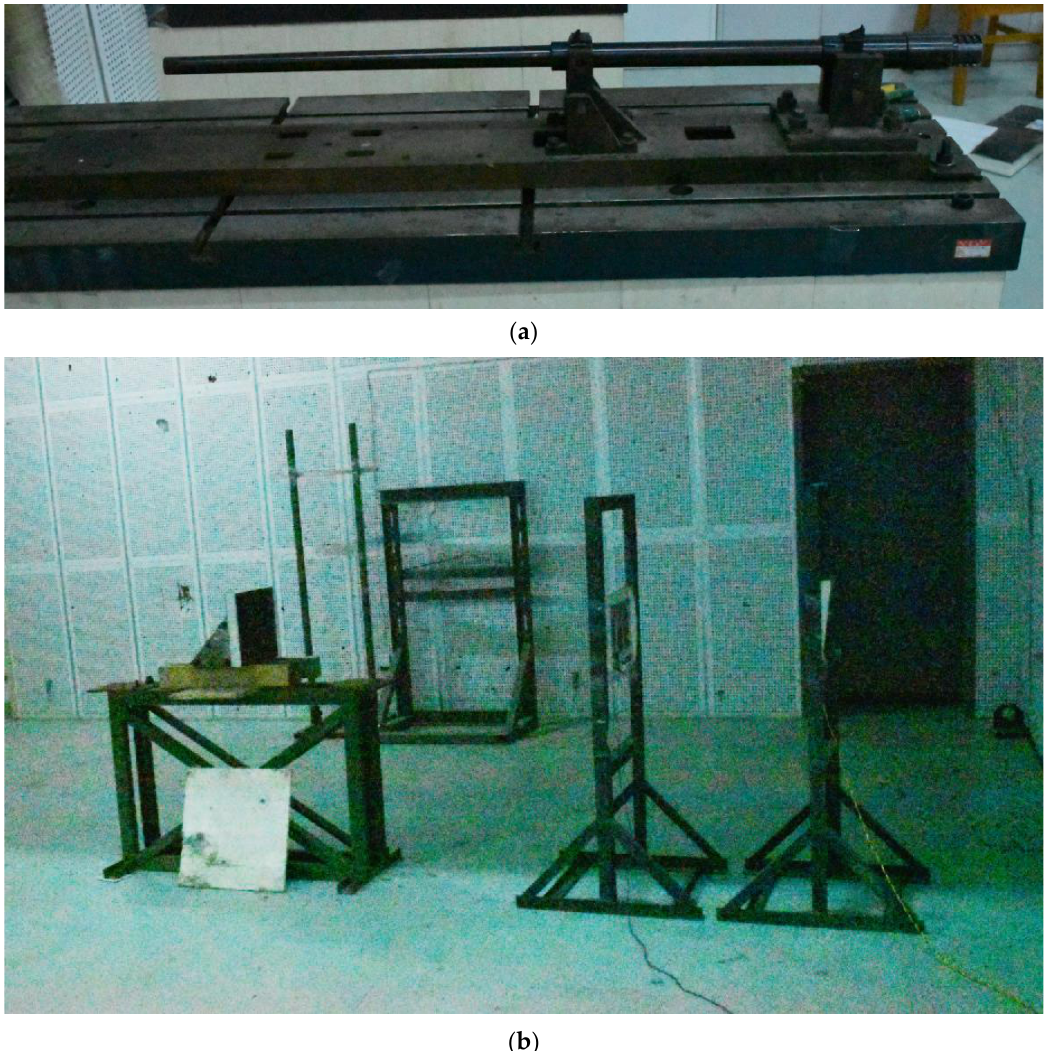
Figure 6. Configuration of the ballistic impact experiment. ( a ) 14.5 mm caliber smooth – bore gun. ( b ) Layout of the targets.